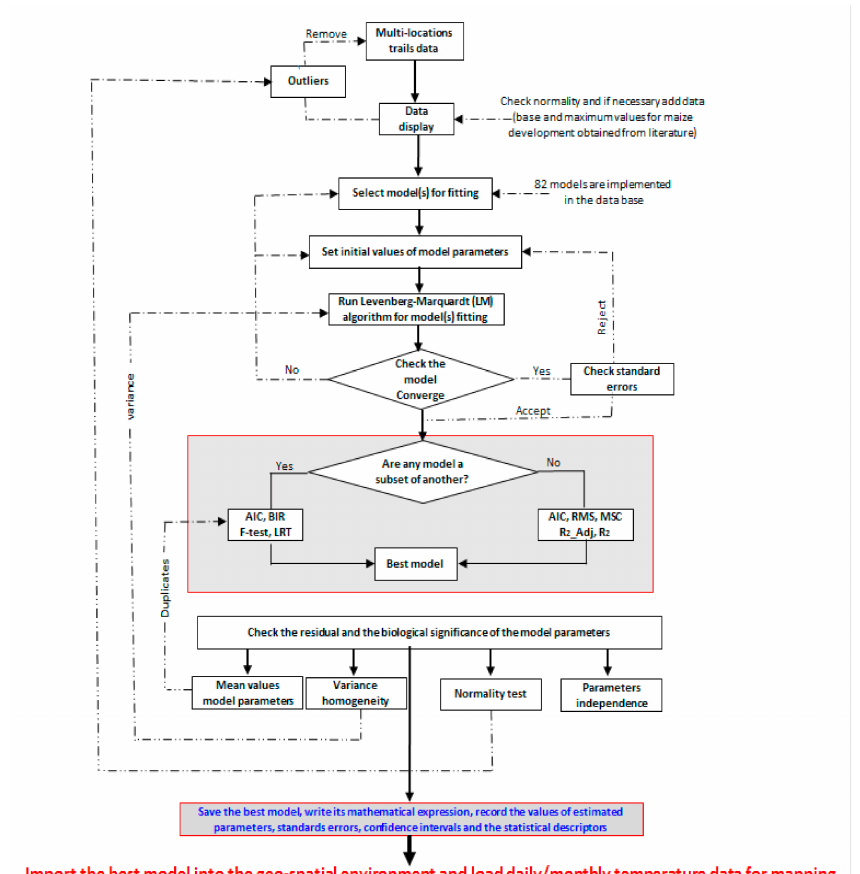
Figure 2. Flow chart demonstrating the steps within the PPMaP software from fitting plant phenology data obtained from multi-trails location to model selection and mapping. The thick, thin and dashed arrows are the essential steps, substeps, and feedback respectively. Akaike’s Information Criterion (AIC), Model Selection Criterion (MSC), Likelihood Ratio Test (LRT), Bayesian Information Criterion (BIC) (Adapted from Archontoulis and Miguez,